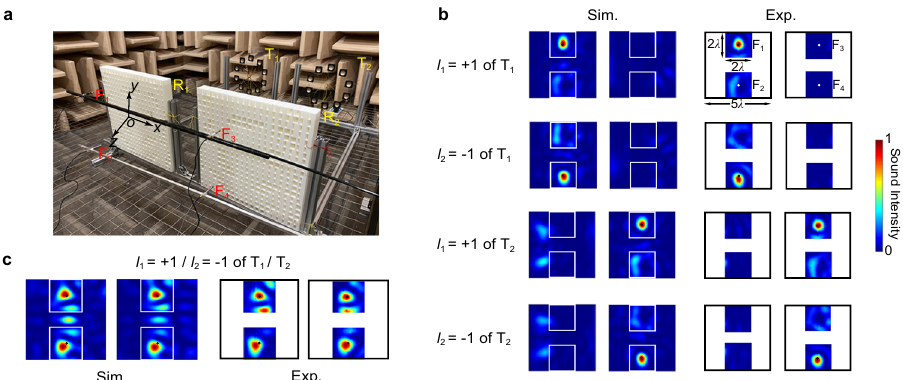
Fig. 2 | Experimental setup for our proposed communication system utilizing multipath twisting of acoustic wave and typical measured results. a Photograph of the experimental setup of 2-paths 4-channels communication system. Two metamaterial-based demultiplexers are placed in alignment with correspondingtransmitterswitharelativedistanceof1.2m.Fourmicrophonesare